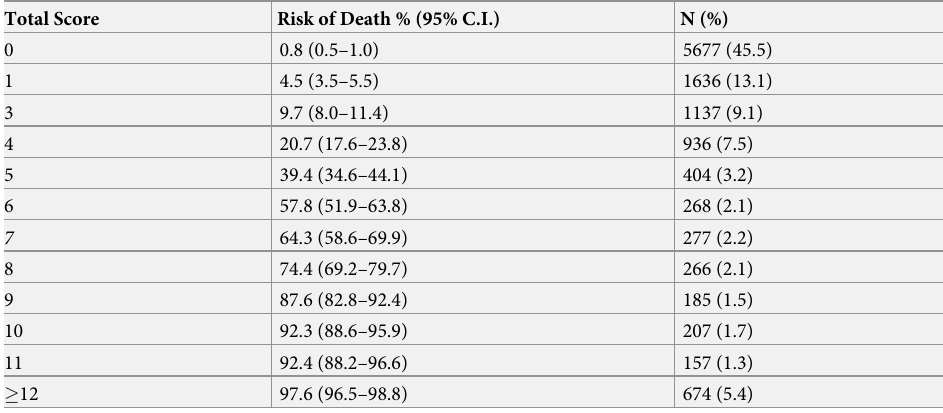
Table 3. Total point score and risk of in-hospital